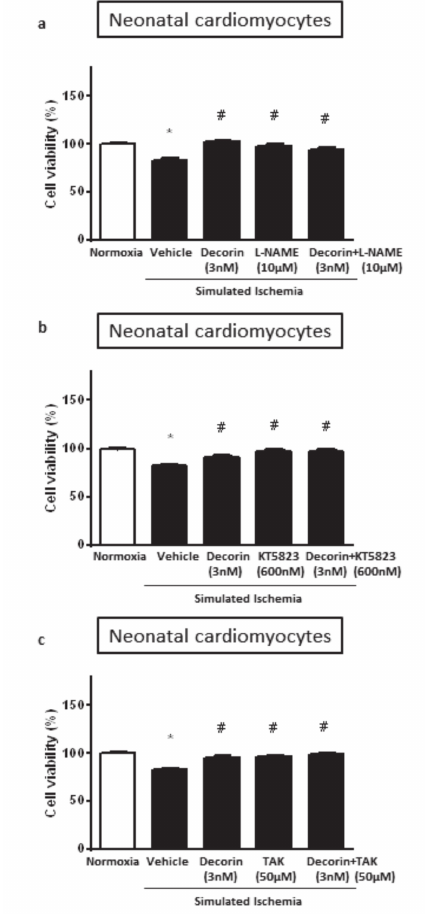
Figure 3. The e ff ect of 3 nM decorin and following inhibitors alone or in combinations: ( a ) 10 µ M L-NAME (NOS inhibitor); ( b ) 60 nM KT-5823 (PKG inhibitor); and ( c ) 50 µ M TAK-242 (TLR-4 inhibitor); on the cell viability in NRCMs exposed to SI / R. Data are normalized to vehicle-treated Normoxia and presented as mean ± S.E.M. One-Way ANOVA, Dunnett’s multiple comparison test, * p < 0.05 vs. Normoxia and # p < 0.05 vs. Vehicle treated cells ( n =